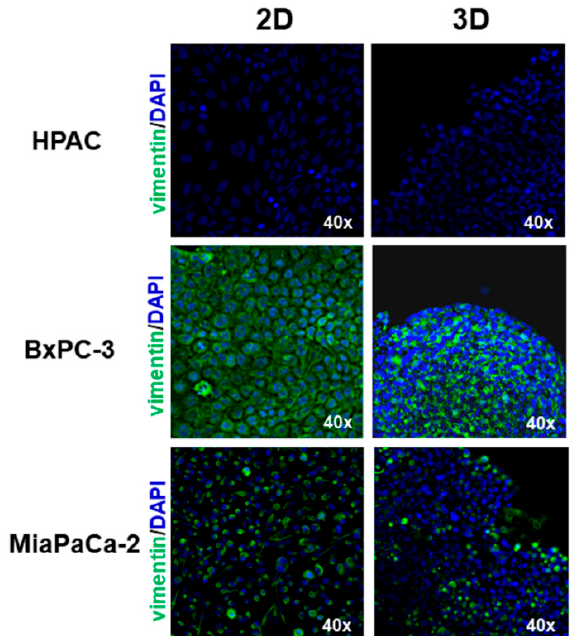
Figure 3. Immunofluorescence analysis for the mesenchymal marker vimentin (green) in PDAC cells cultured in 2D monolayers and 3D spheroids, showing that vimentin expression is detectable in BxPC-3 and MIA PaCa-2. Original magnification: 40×.